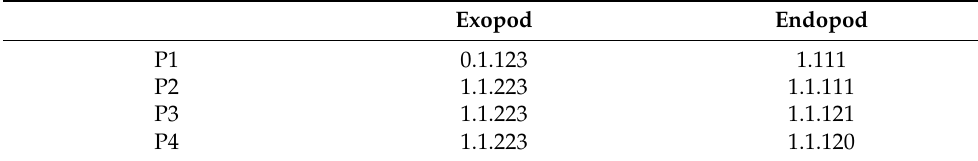
Table 3. Armature formulae of legs